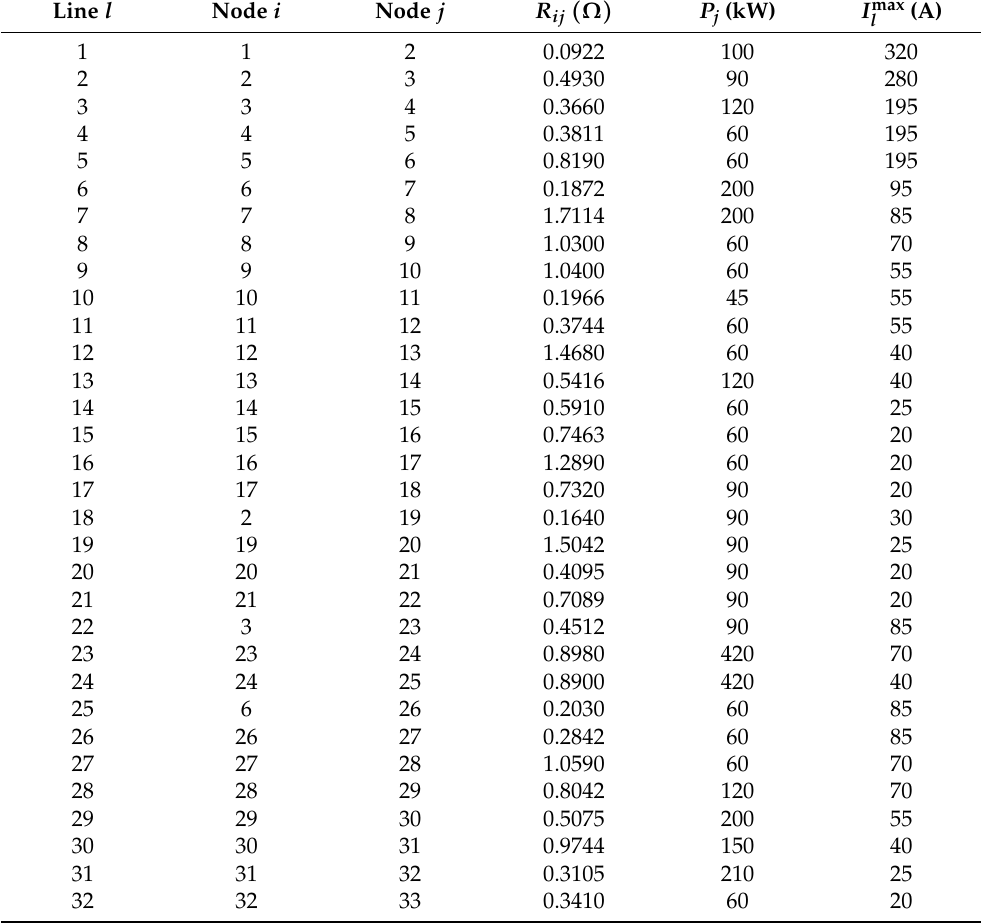
Table 1. Network data regarding branches and